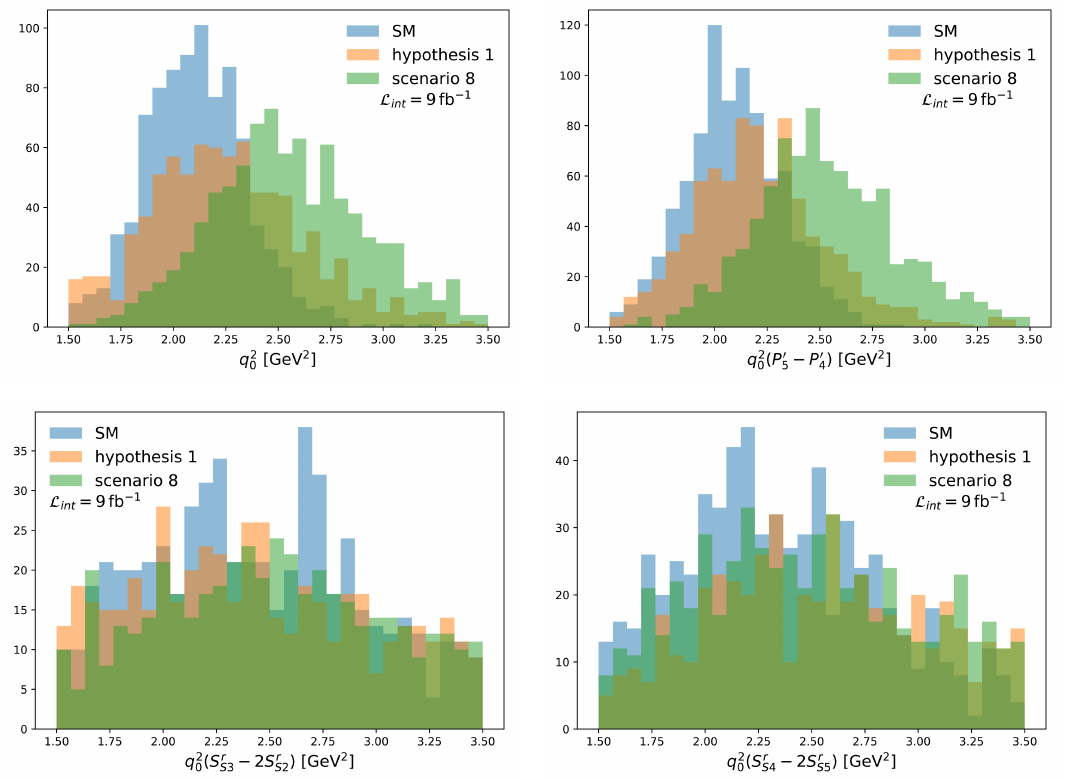
Figure 22 . Distributions of measured zero crossing points with 9 fb − 1 of data. Shown are the (top left) common fitted zeros and the independent zeros of (top right) P 0 and (bottom right) S r